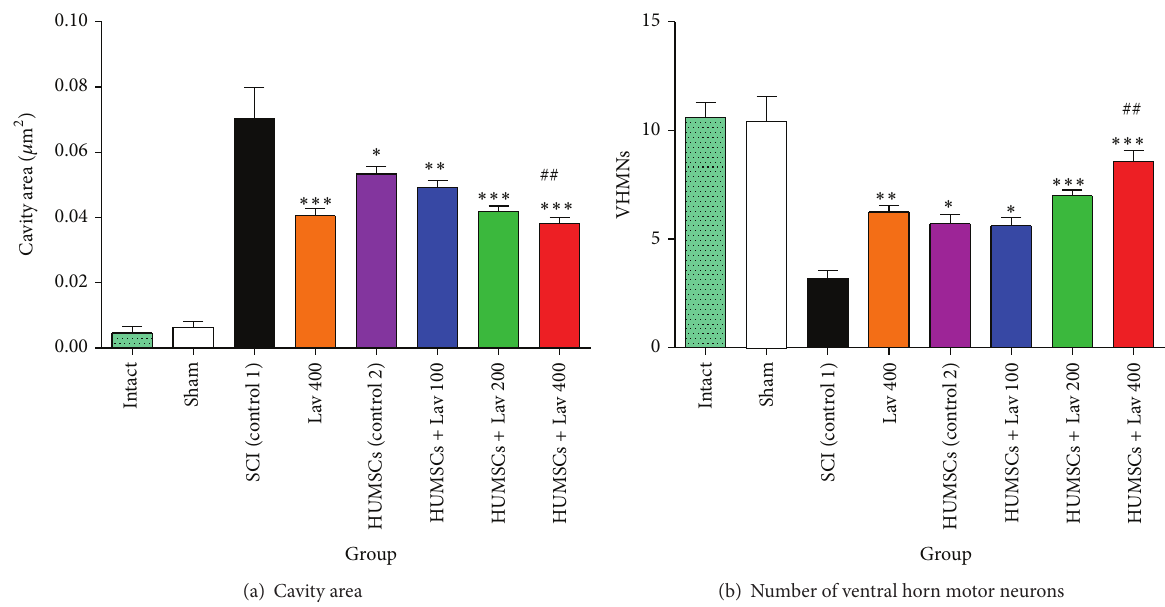
Figure 3: HUMSCs transplantation and administration of L. angustifolia improved histomorphological results, decreased cavity area (a), and increased the number of VHMNs (b) in the rat spinal cord contusion model. Intraperitoneal administration of L. angustifolia extract daily for 14 consecutive days after injury significantly improved histomorphological results including cavity area and VHMNs results. Data are represented as the mean ± S.E.M. ∗ , ∗∗ , and ∗∗∗ show significant differences of HUMSCs, HUMSCs + Lav 100, 200, and 400 compared to SCI (control 1) group ( 𝑃 < 0.05 , 𝑃 < 0.0001 , and 𝑃 < 0.0001 , resp.). ## shows significant differences between HUMSCs + Lav 400 and HUMSCs (control 2) ( 𝑃 < 0.001 ). Cavity area significantly decreased in HUMSCs and HUMSCs + Lav-treated groups (a) (Per 35625 𝜇 m 2 ). Number of ventral horn motor neurons significantly increased in HUMSCs and HUMSCs + Lav-treated groups (b) (Per 5700 𝜇 m 2 ).